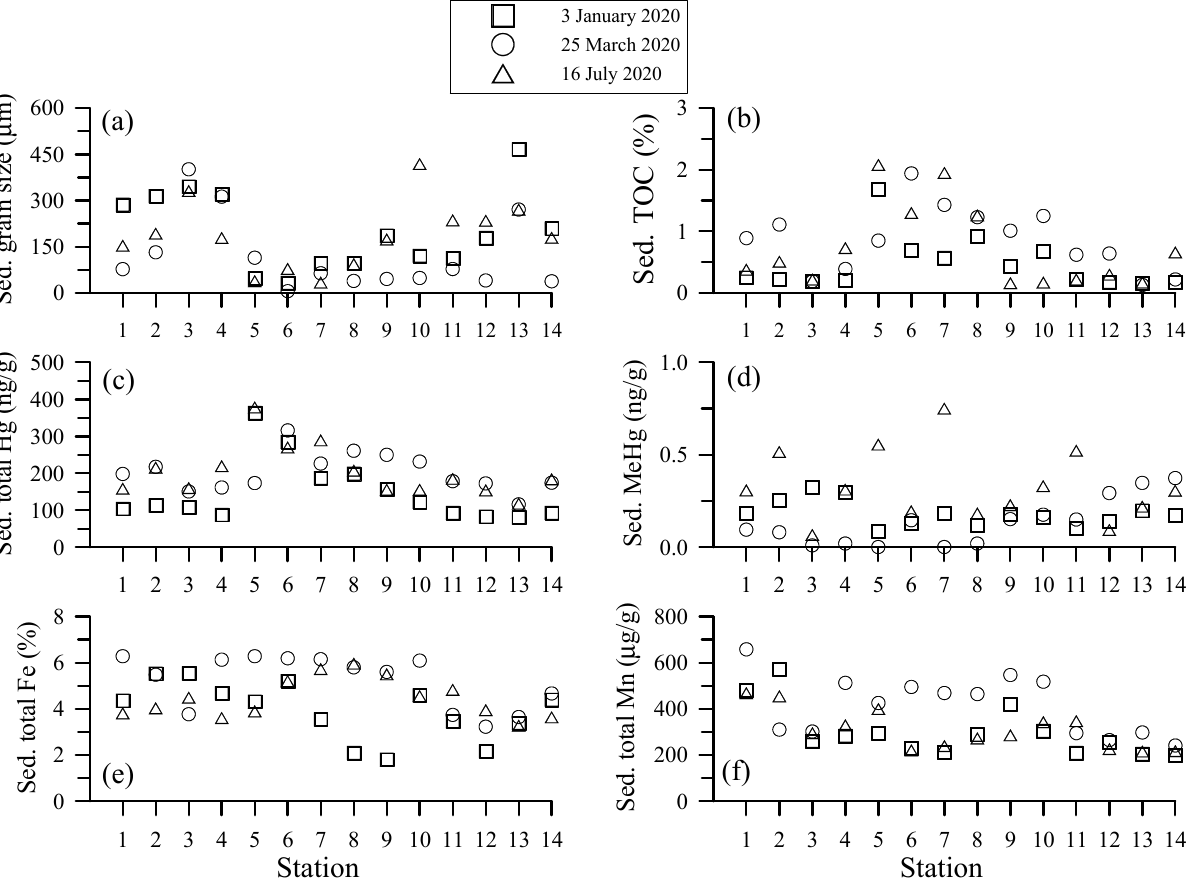
Figure 4. Scatter plots of ( a ) grain size, ( b ) TOC, ( c ) total Hg, ( d ) MeHg, ( e ) total Fe and ( f ) total Mn concentrations in sediment samples at the studied stations in the Danshuei River Estuary, northern Taiwan.